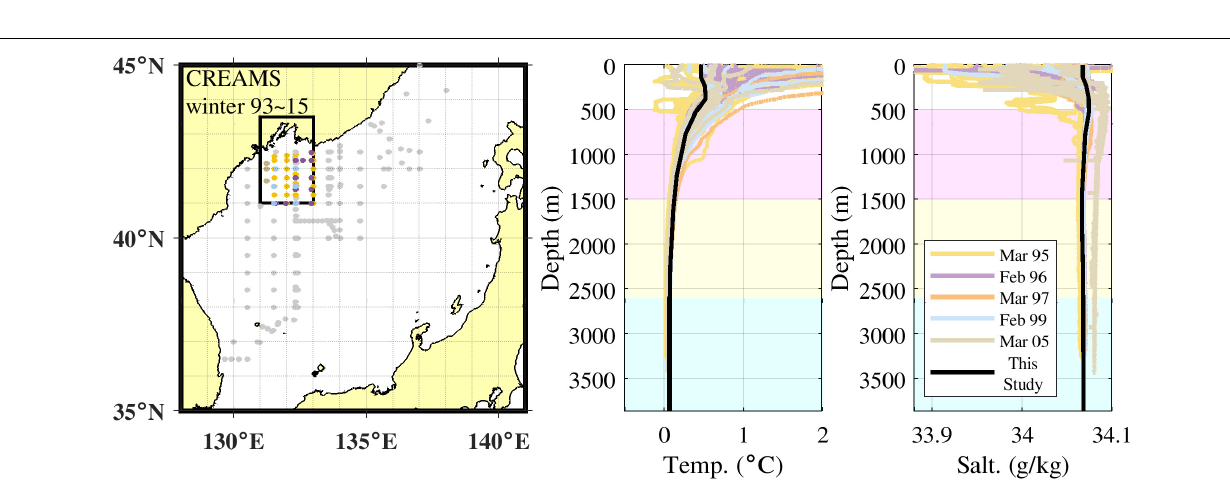
FIGURE 2 | (Left panel) CTD stations south of Vladivostok during the CREAMS winter cruises from 1993 to 2015 (colored dots). (Right panels) Colored lines represent vertical potential temperature and salinity profiles during each CREAMS cruise. Black solid lines are potential temperature and salinity profiles selected for numerical experiment initialization. Background colors represent the water masses in the EJS based on Kim et al. (2004) (magenta: CW, yellow: DW, cyan: